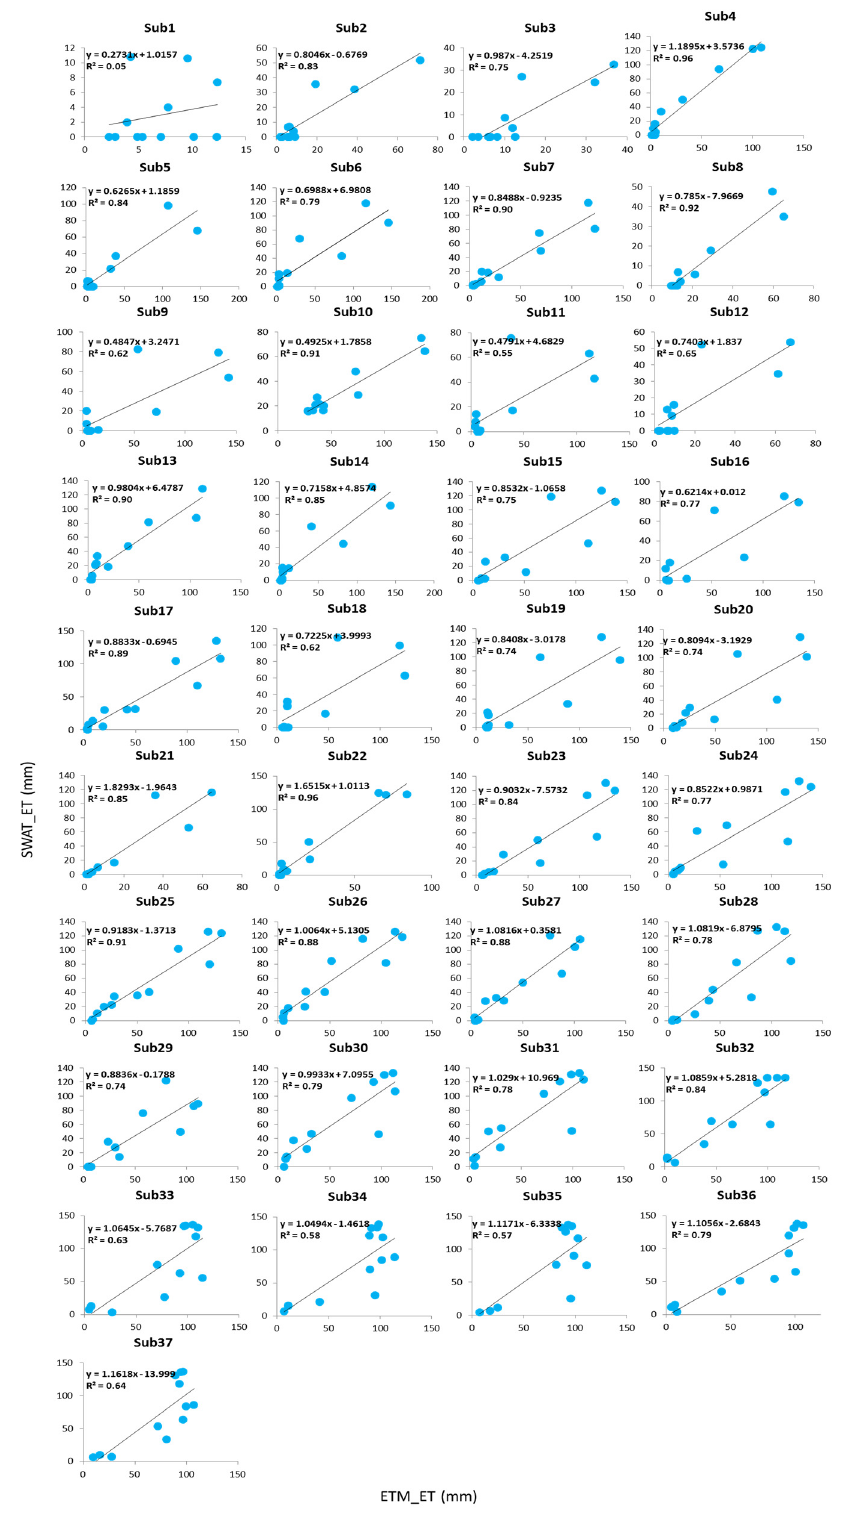
Figure 4. Comparison between ETMonitor ETa and SWAT-calibrated ETa for all sub-catchments in the LCB.